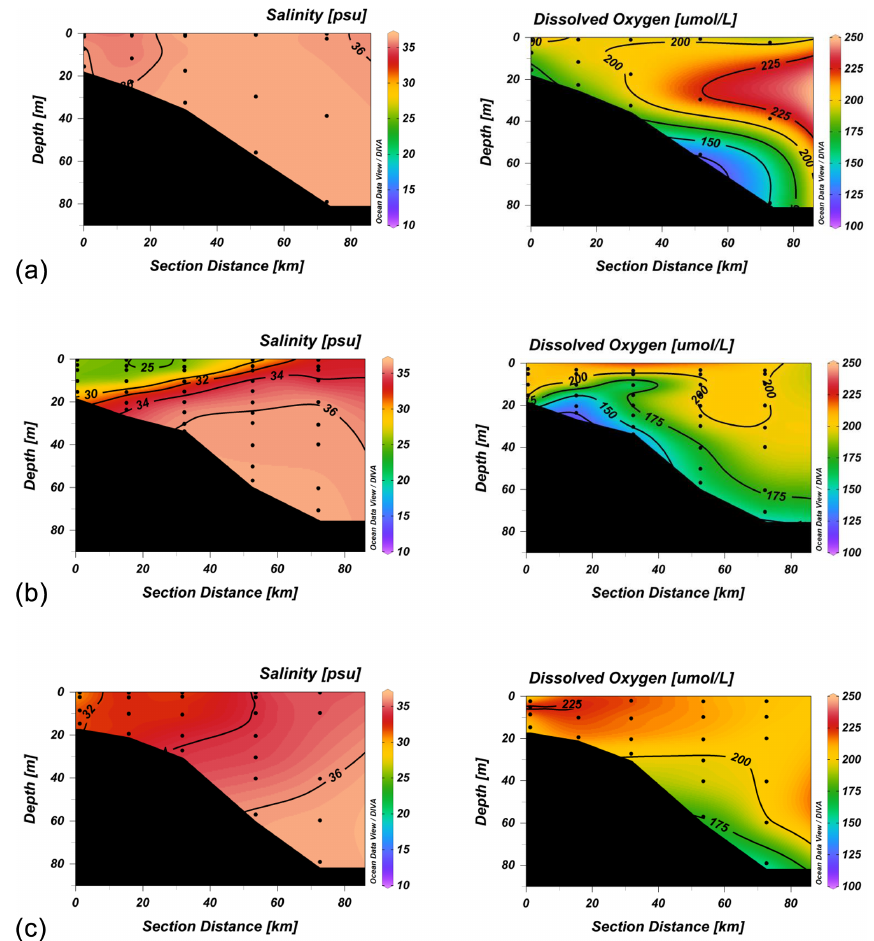
Figure 5. Salinity (psu) and oxygen (µmolL − 1 ) sections across line 3 (stations 11–15) for the August cruse (a) , the first September cruse (b) and the November cruise (c)